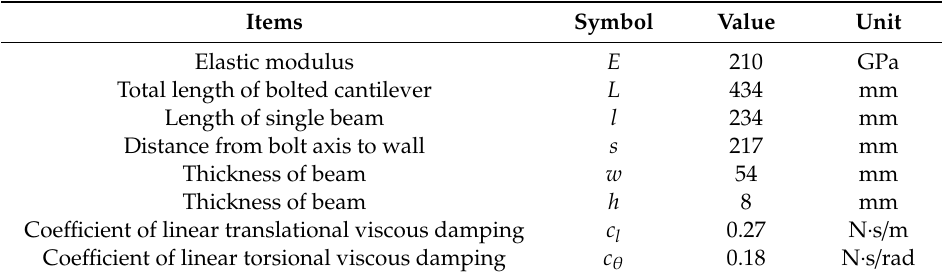
Table 1. Physical parameters of bolted cantilever beam.